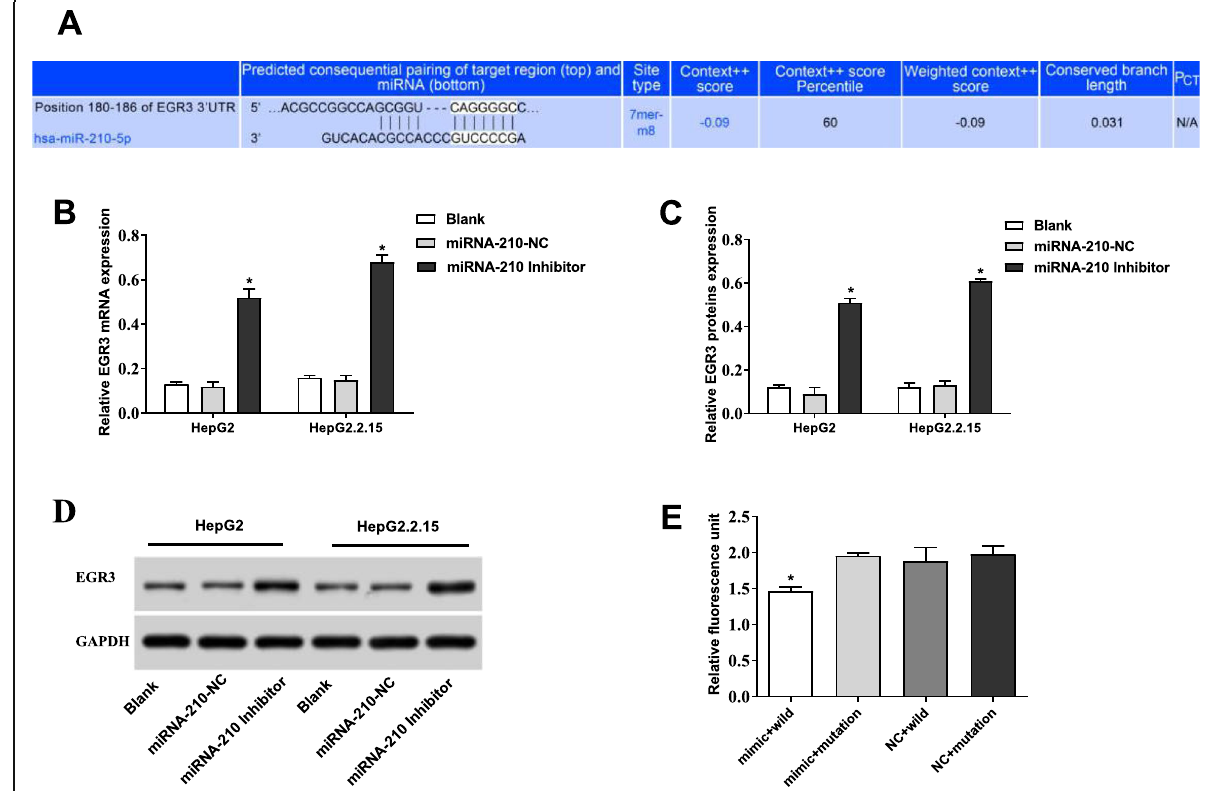
Fig. 5 EGR3 was a target of miRNA-210. a A binding site at 3 ′ -UTR of EGR3 was predicted on miRNA-210 by Target Scan. b-d Silencing of miRNA- 210 increased the mRNA and protein expression of EGR3. * P < 0.05 compared with the Blank group. e The relative fluorescence unit was significantly decreased in the mimic + wild group. * P < 0.05 compared with the mimic + mutation group. All experiments were performed in triplicate, and data were expressed as mean ± standard deviation